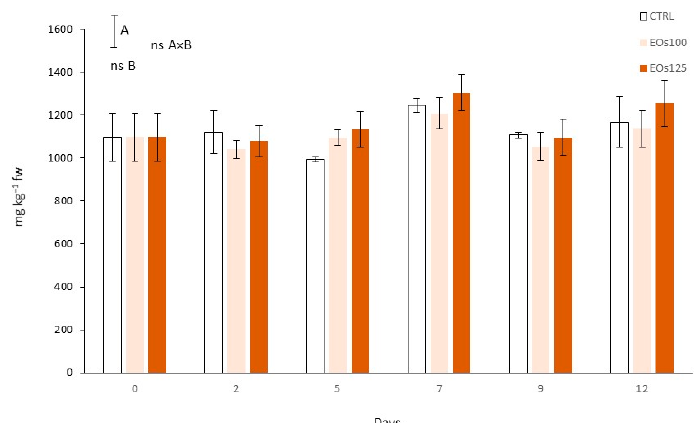
Figure 4. Total phenolic content of sliced mushroom during cold storage (4 °C) under modified atmosphere packaging supplemented with vapour essential oils (100 and 125 µ L L − 1 EOs) (mean ± standard deviation). Least significant differences are represented as bars, with A and B letters for the treatment and storage time factors, respectively. ns, not significant.